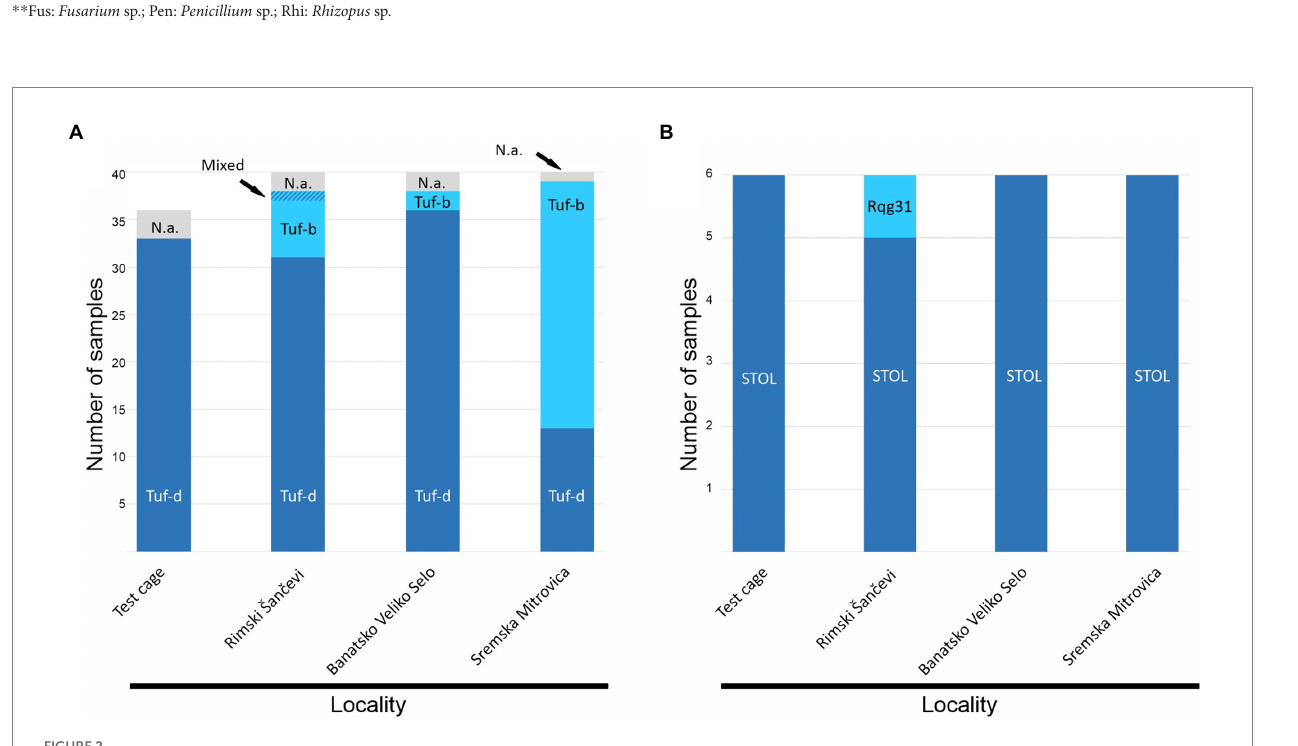
FIGURE 2 Molecular characterization of ‘ Candidatus Phytoplasma solani’ based on (A) tuf gene (B) stamp gene. N.a. not